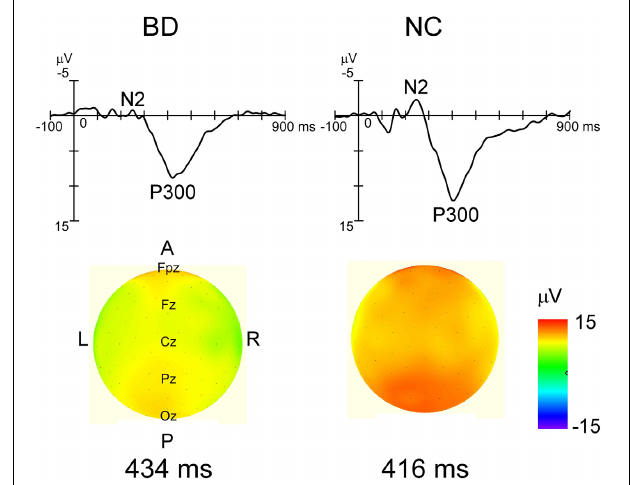
FIGURE 4 | Grand averaged waveforms in response to target stimulus at Pz and topographical maps of P3 in each group. Distinct N2 and robust P3 were observed in each group’s waveforms. While P3 latency was not significantly different between the two groups, P3 amplitudes were significantly smaller in the BD group ( P < 0 . 05). The P3 amplitude gradient for the NC group is steeper than that in the BD group, which roughly corresponds to the statistical